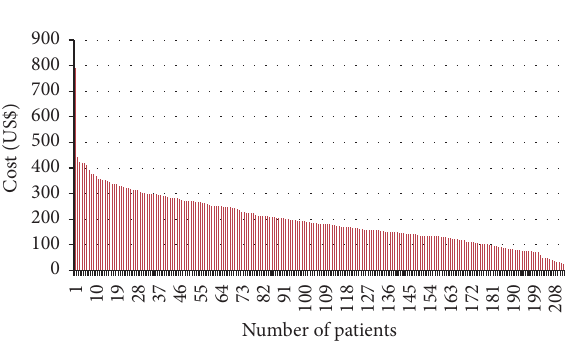
Figure 4: Cost distribution for ARV